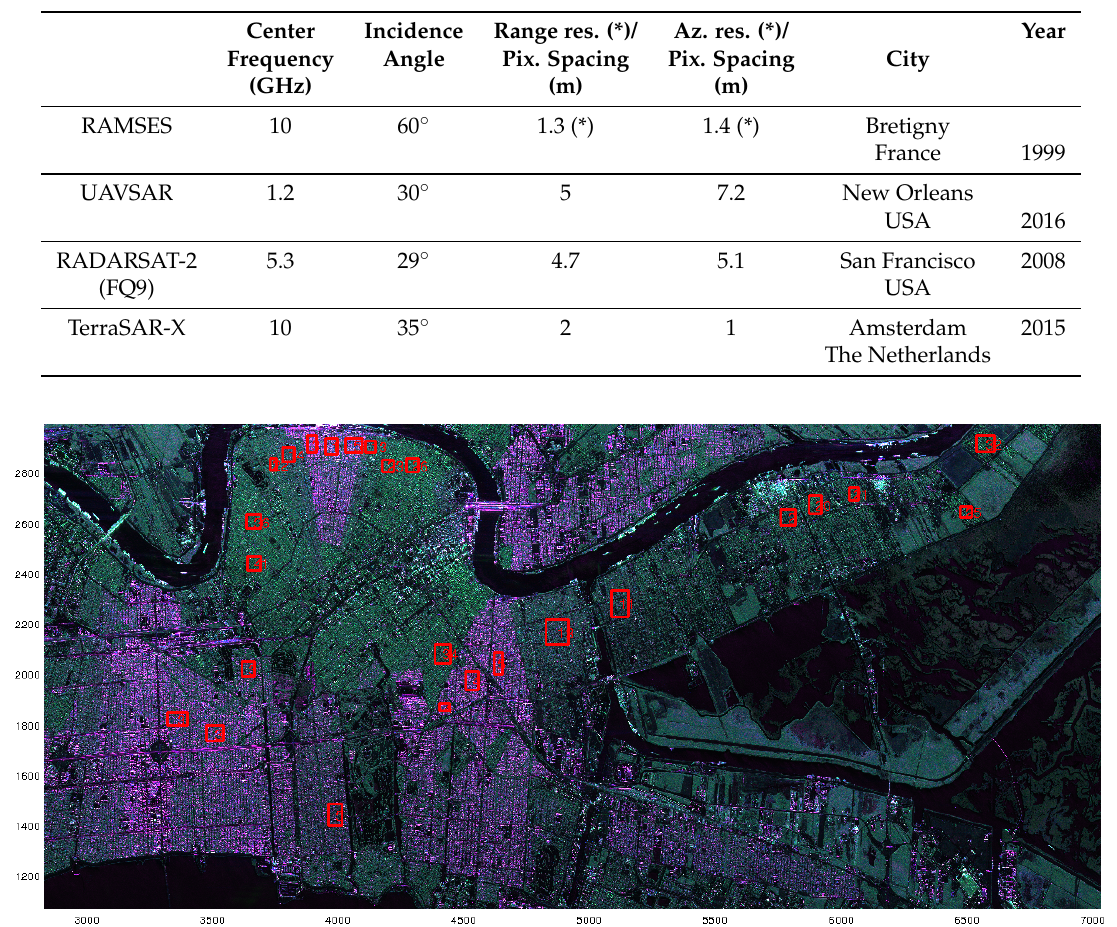
Table 1. Radar characteristics of the sensors for the images considered for this study.